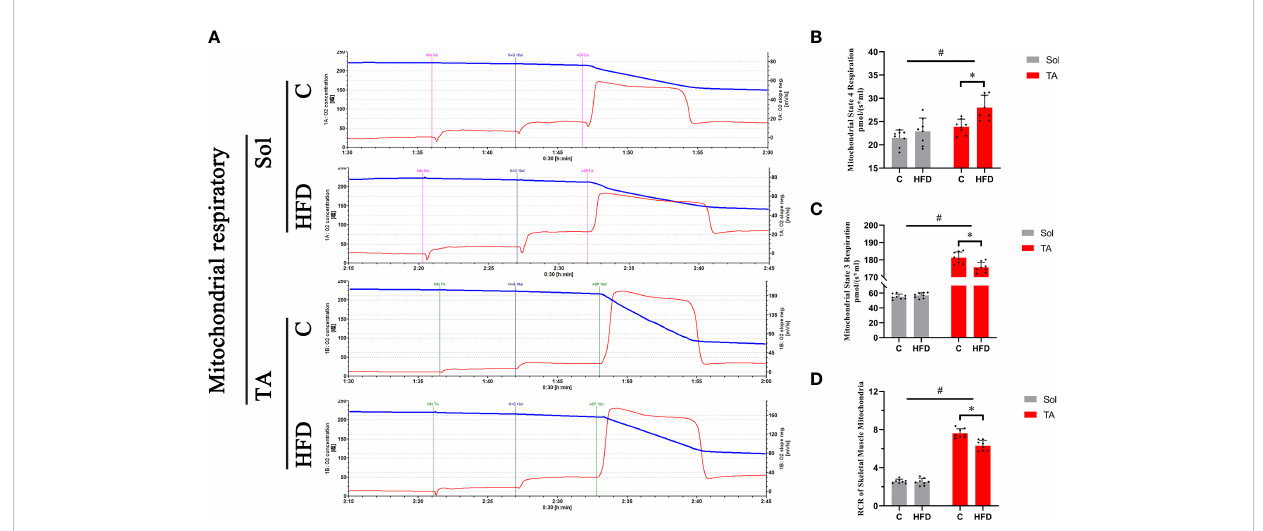
FIGURE 3 Mitochondrial respiratory functions in fast- and slow-twitch muscles after HFD intervention. Traces of mitochondrial O 2 consumption (A) , Mitochondrial State 4 (B) and State 3 (C) respiration and the respiratory control rate (D) in the Sol and TA under stimulation with the respiratory chain substrate (malate+glutamate) are shown. (*p<0.05; n=8 for each group).